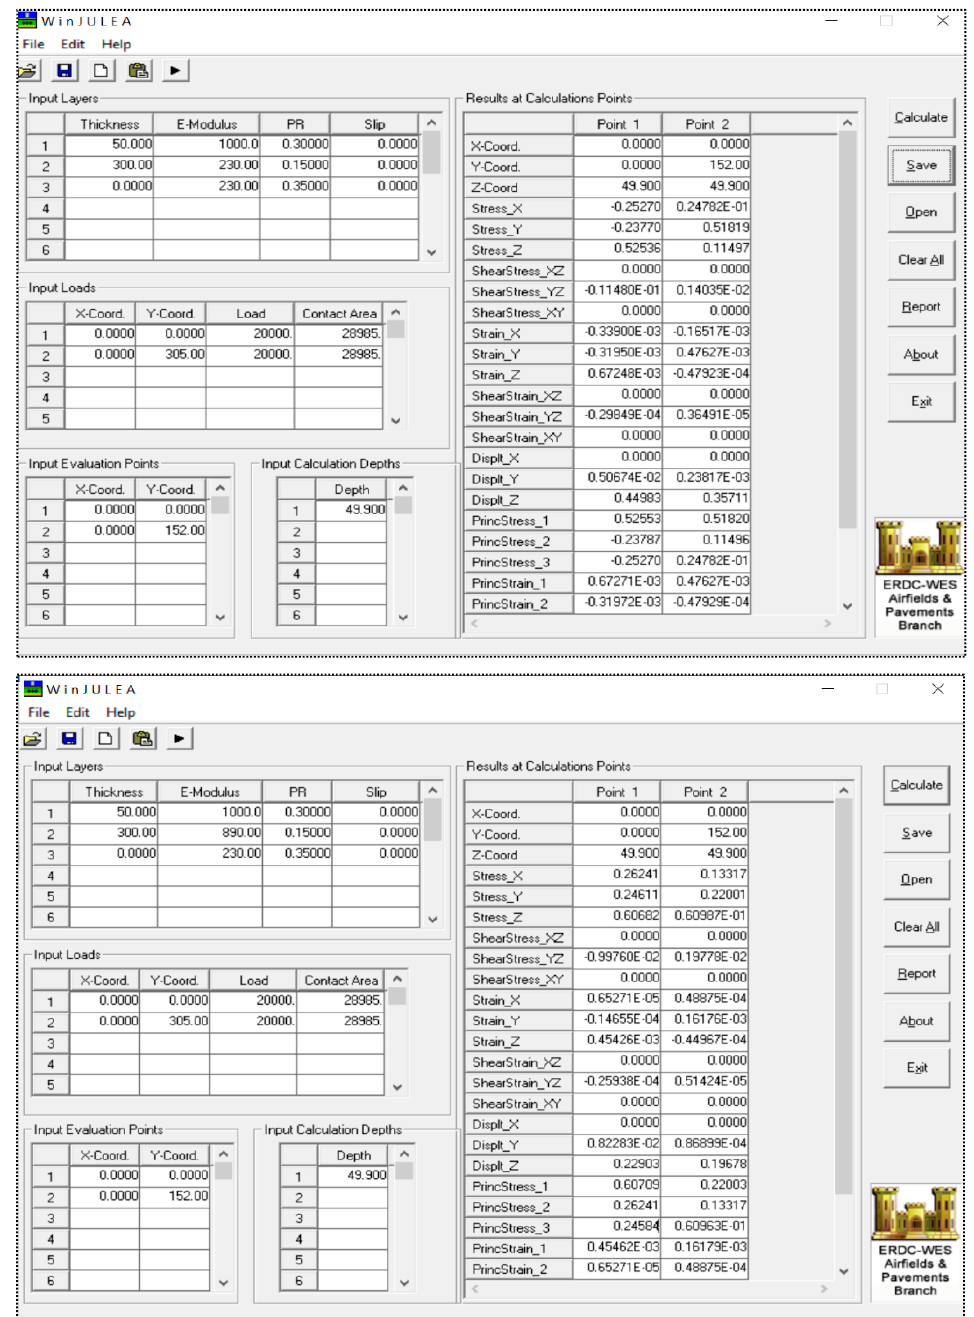
Figure 8. Comparative structural analysis (100%; 0%) on top of figure vs. (30%:70%) and 7% FA + Figure 8. Thickness saving in pavement layers for untreated and treated 5% OPC at bottom of figure.